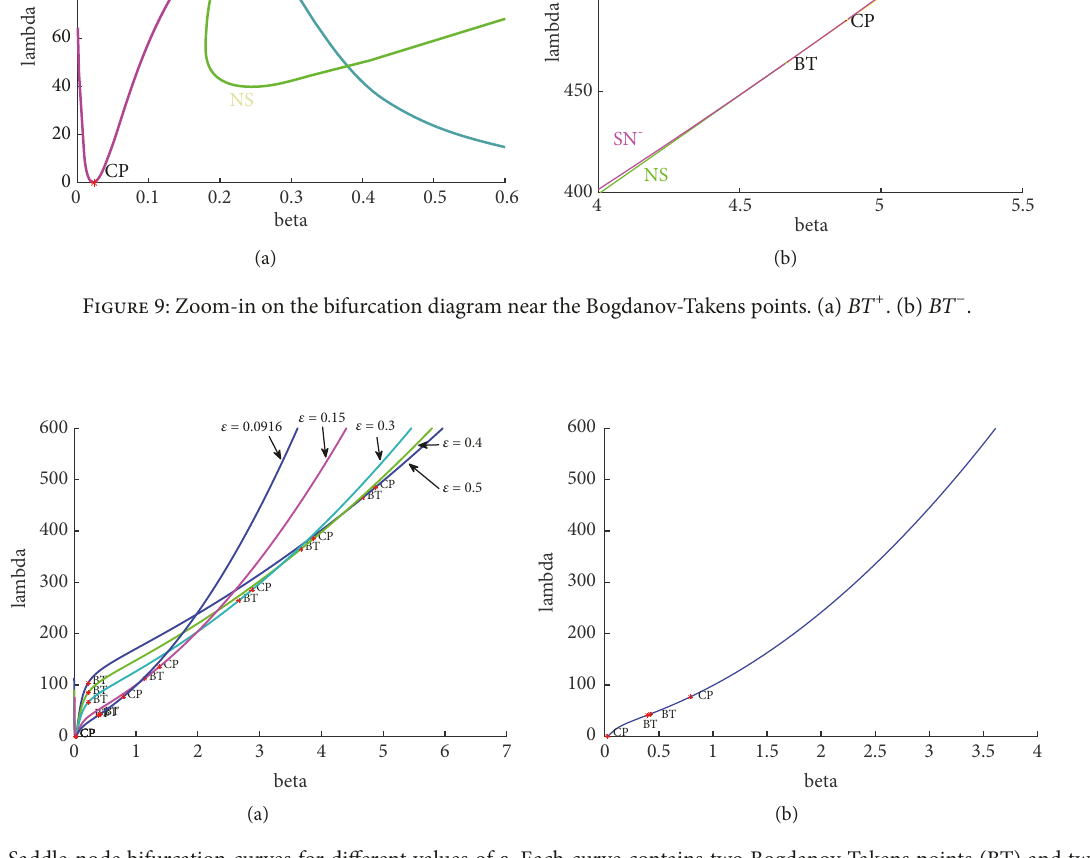
Figure 10: Saddle-node bifurcation curves for different values of 𝜀 . Each curve contains two Bogdanov-Takens points (BT) and two cusp bifurcation points (CP). (a) Sequence of curves as 𝜀 varies from 0.5 to 0.0916. (b) Curve for 𝜀 = 0.0916 .